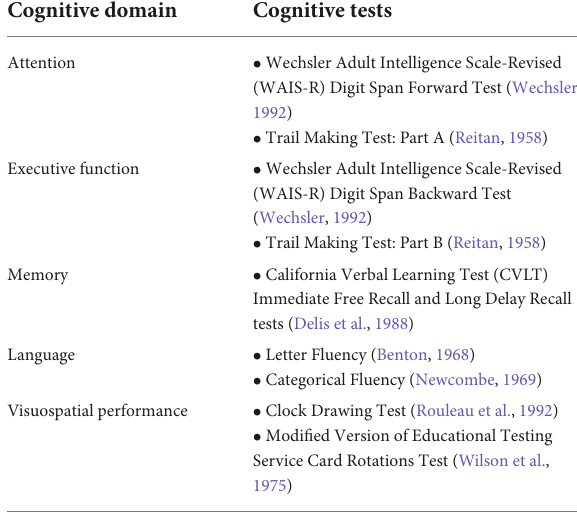
TABLE 2 Cognitive tests in each